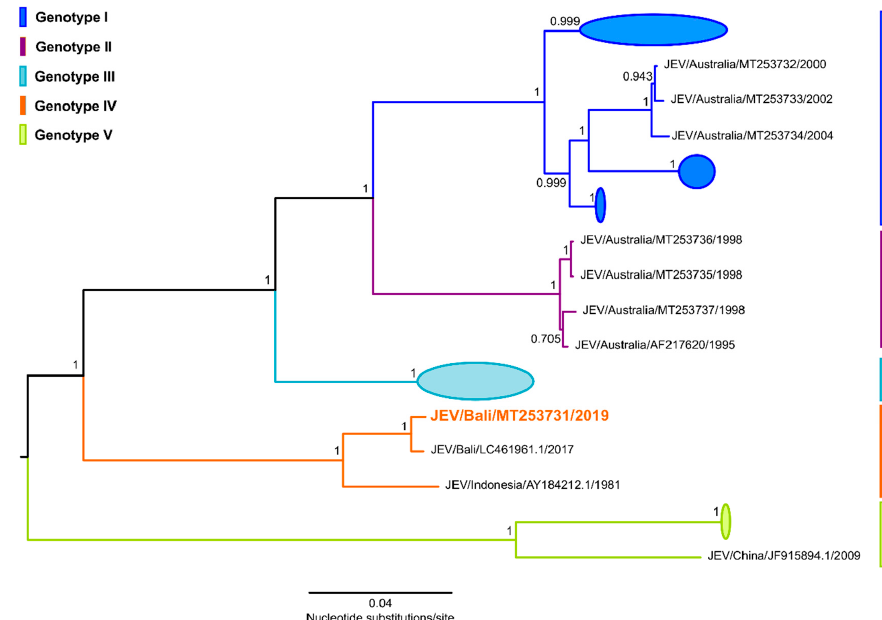
Figure 3. Midpoint rooted, approximately maximum likelihood phylogenetic tree estimated from 243 JEV complete coding region sequences (10,303 nucleotides). Tree construction was performed as previously described [5] using FastTree version 2.1.11 software and the general time reversible (GTR) nucleotide substitution model. Multiple sequence alignments were performed using the Multiple Alignment Using Fast Fourier Transform (MAFFT) program, version 7.450, and Geneious software, version 10.2.6. The five JEV genotypes are shown with major clades collapsed to highlight key JEV strains. Shimodaira–Hasegawa-like local support values are shown for selected nodes. The JEV Bali 2019 strain and corresponding designation within JEV genotype IV is shown in